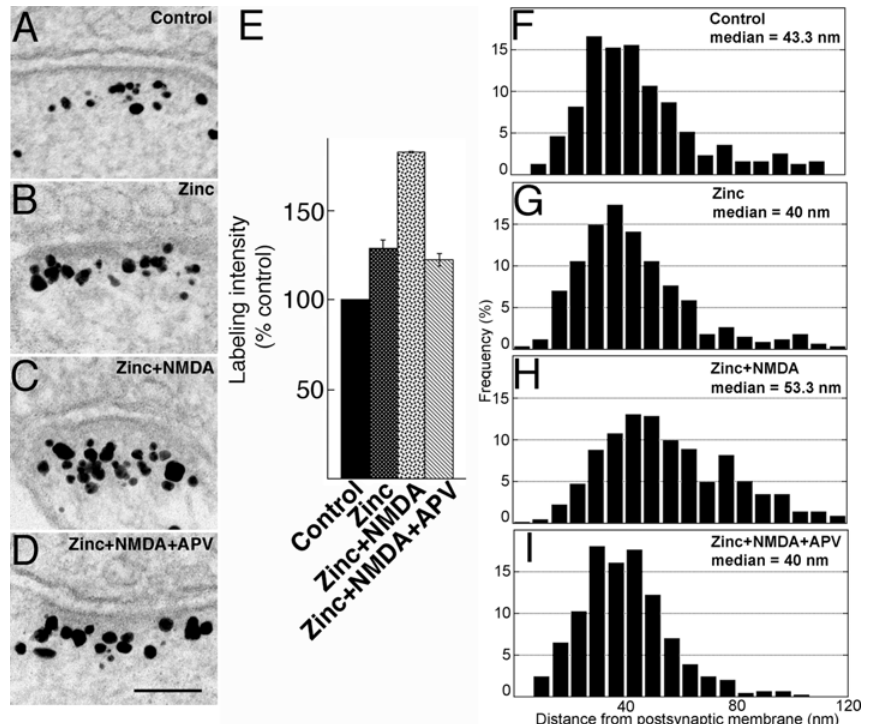
Fig 6. (A-D) Electron micrographs of asymmetric synapses labeled for Shank3 using ab2. Hippocampal cultures were pre-incubated for 1 hr in control medium or in media containing zinc or zinc+APV, followed by a 2 min treatment in the same media with or without NMDA, as indicated. Scale bar = 0.1 μ m. (E) Bar graphs represent combined data (mean ± SEM) from S5 Table. APV appeared to block NMDA-induced, but not zinc- induced, increase in Shank3 labeling intensity at the PSD. (F-I) Laminar distribution and median distances of gold particles from the postsynaptic membrane were similar in control (F) and zinc-incubated samples (G). APV (I) blocked the increase in median distance in zinc+NMDA samples